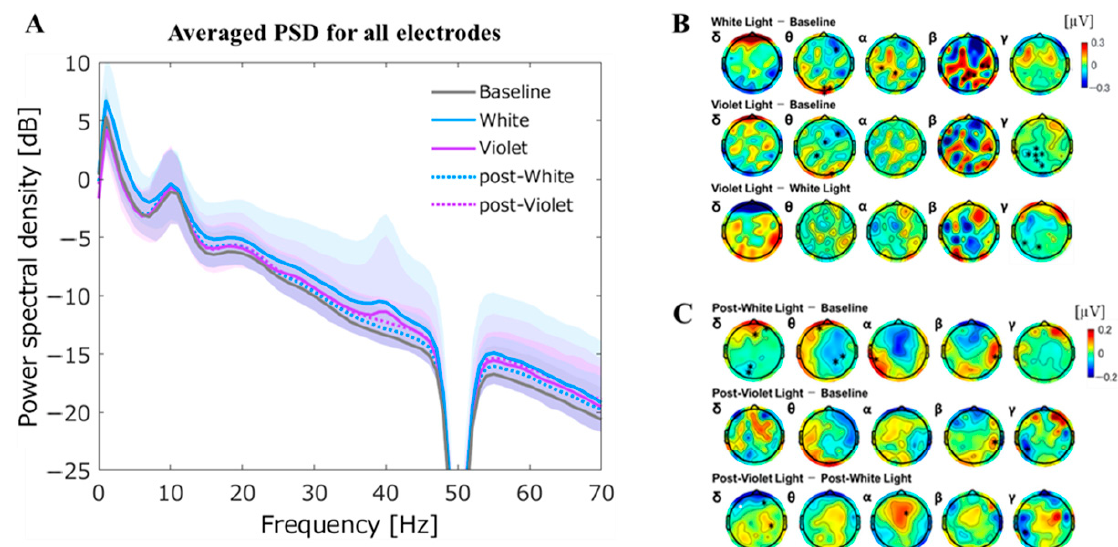
Figure 4. Averaged PSDs for all electrodes during and after the light stimulation and their topographical plots. ( A ) shows the averaged power spectrum density (PSD) over all electrodes for each condition; ( B ) depicts topographical plots of PSDs during the light stimulation; ( C ) demonstrated topographical plots of PSDs after the light stimulation. Of note, black asterisks indicate significant findings at the 0.05 level of significance, while white asterisks indicate significant findings at the 0.01 level of significance. The graph is shown with ± S.D. shadows to the mean PSD for each